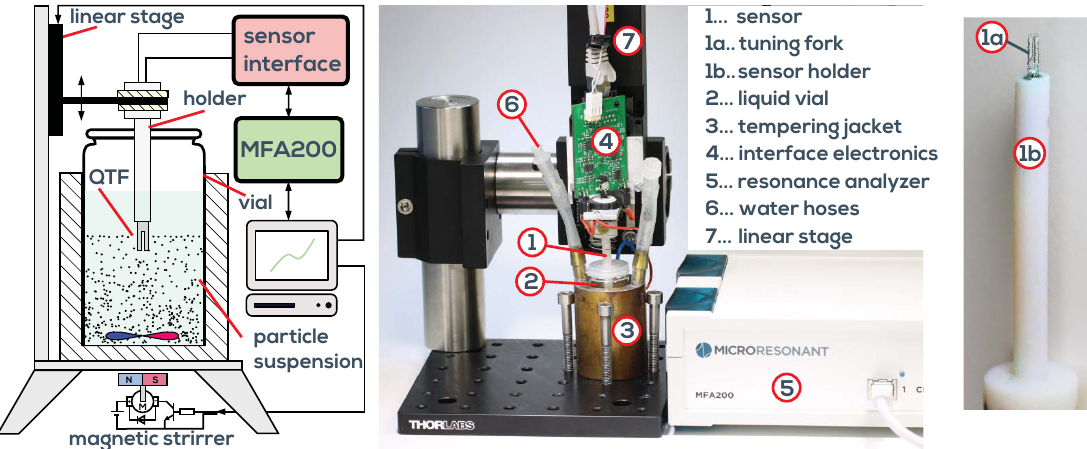
Figure 13. Particles are repeatedly stirred and their sedimentation is monitored using the QTF setup. Temperature is stabilized by means of an externally connected bath circulator.